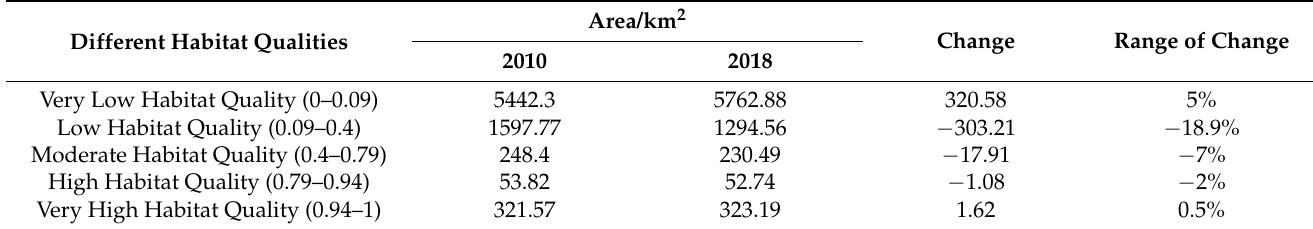
Table 3. Area and proportion of different levels of habitat